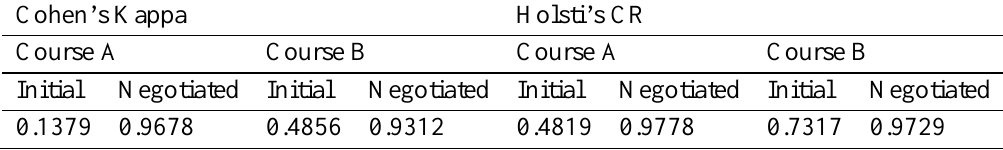
Instructor Discussion